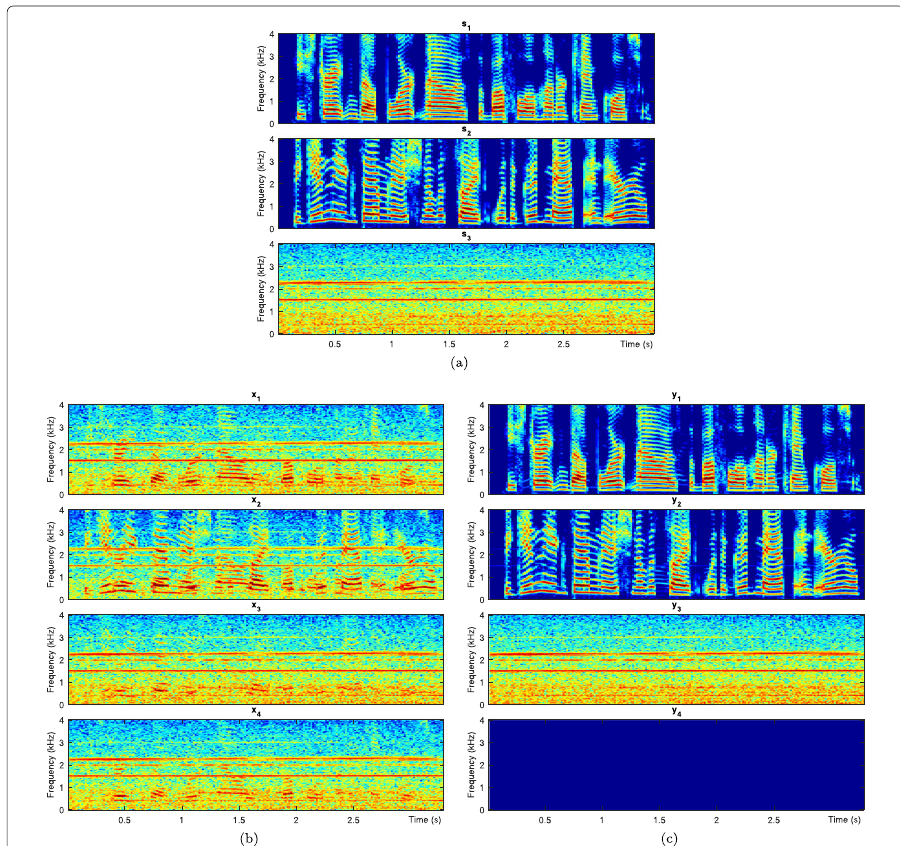
Fig. 4 Extraction of speech signals. a Original speech signals. b Mixtures of two speech signals and one noise source projected onto four-dimensional space. c Source signals estimated using the proposed